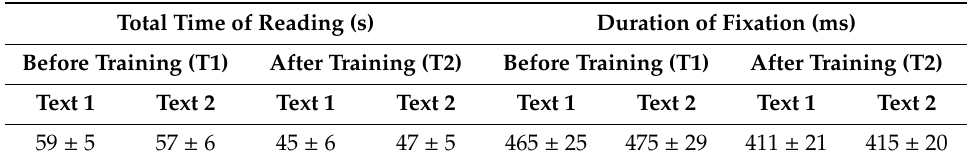
Table 3. Mean and standard deviations of the total time of reading and of duration of fixation for children of G1 = experimental group, who read Texts 1 and 2 before and after training (in T1 and T2). Total Time of Reading